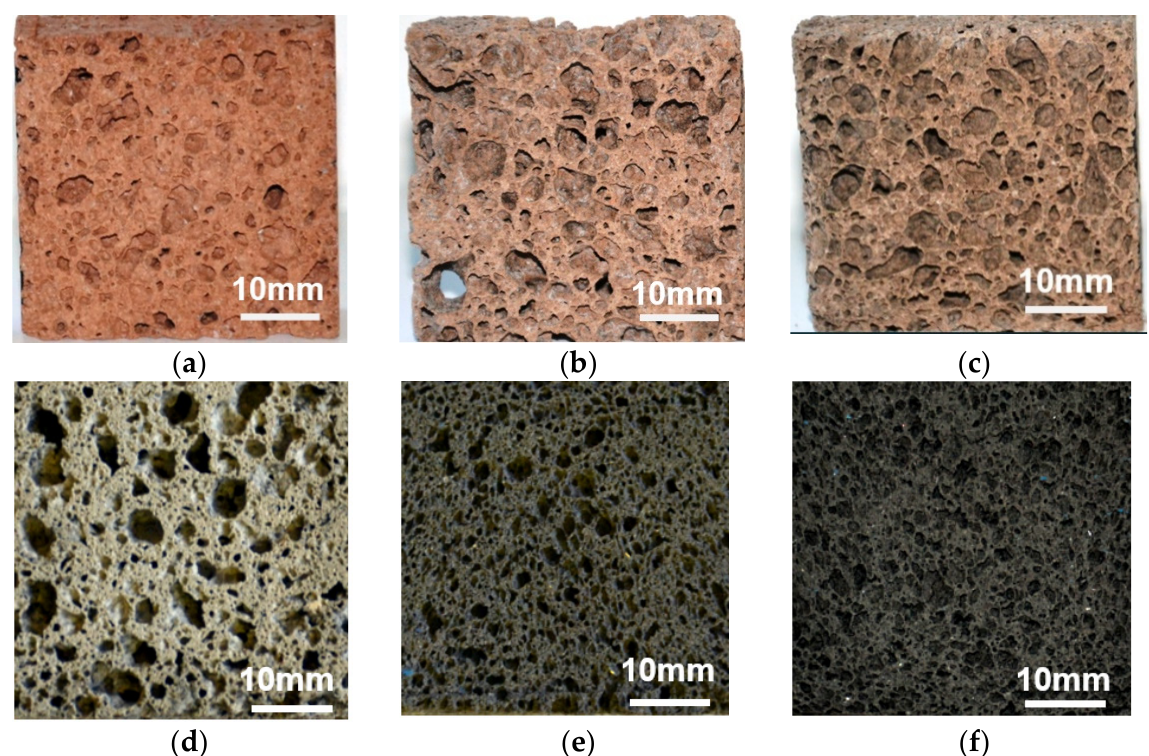
Figure 1. Macrostructure of porous geopolymers: ( a ) IC-0.1SL-Q, ( b ) IC-0.5SL-Q, ( c ) IC-1.0SL-Q, ( d ) MK-0.1SL-Q, ( e ) MK-0.5SL-Q, ( f ) MK-1.0SL-Q.